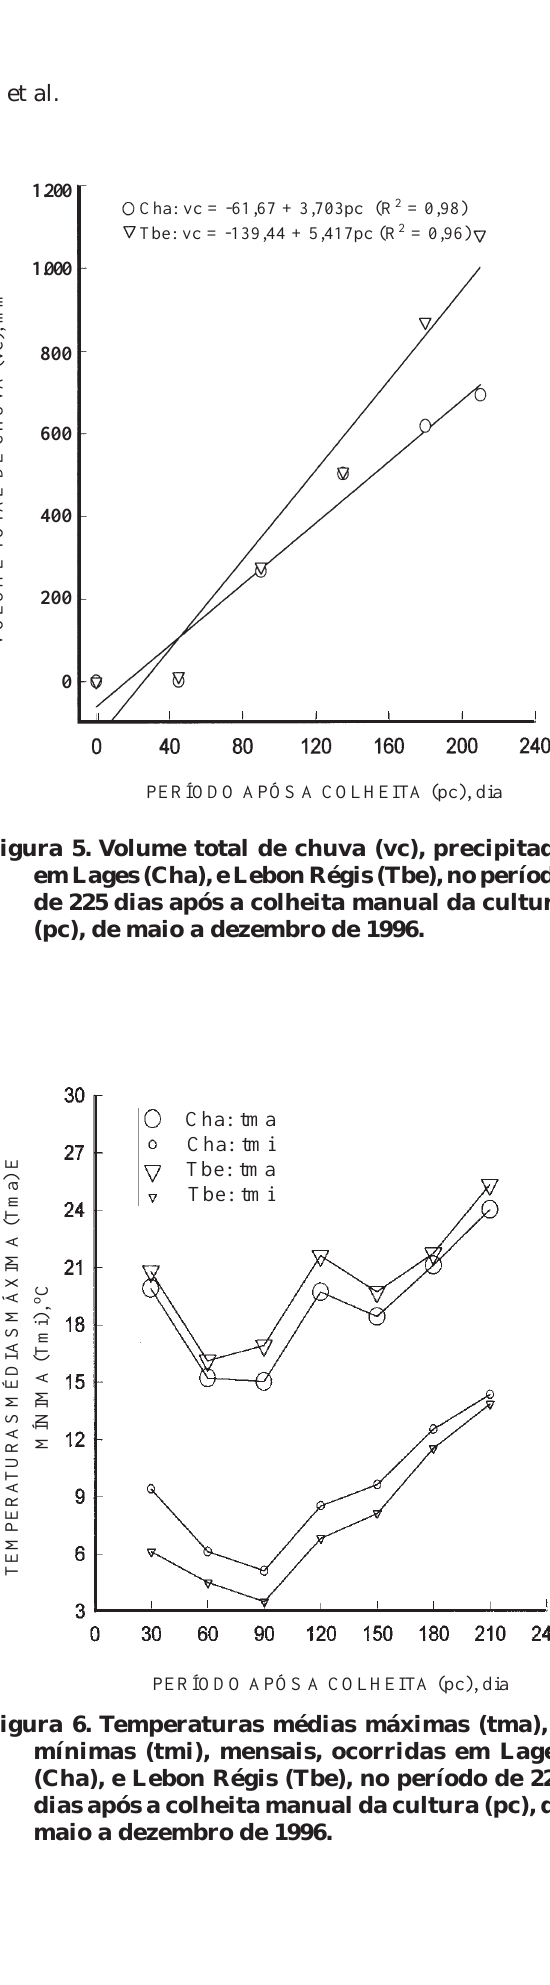
R. Bras. Ci. Solo, 22:705-712, 1998